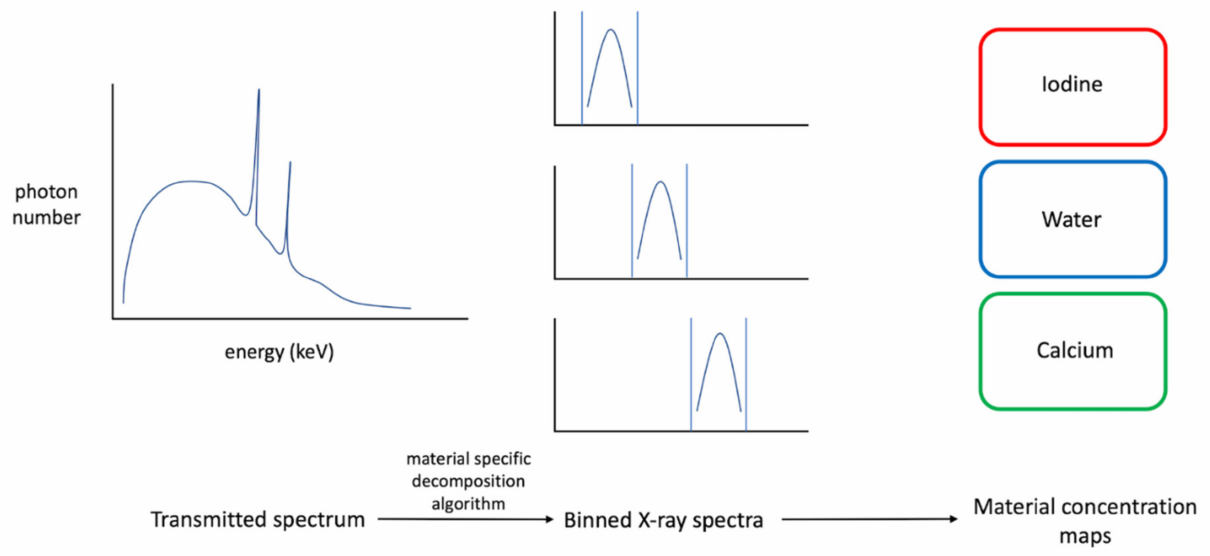
Figure 2. Graphical representation of the ability of the photon-counting system to determine different energy spectra. In particular, the system is capable, by subtracting the raw CT data with defined low-energy thresholds to obtain differentiated data based on the “energy bin” to which it belongs and produce different maps based on the concentration of the materials under examination after spectrum processing by specific material decomposition algorithm (e.g., iodine, water, and